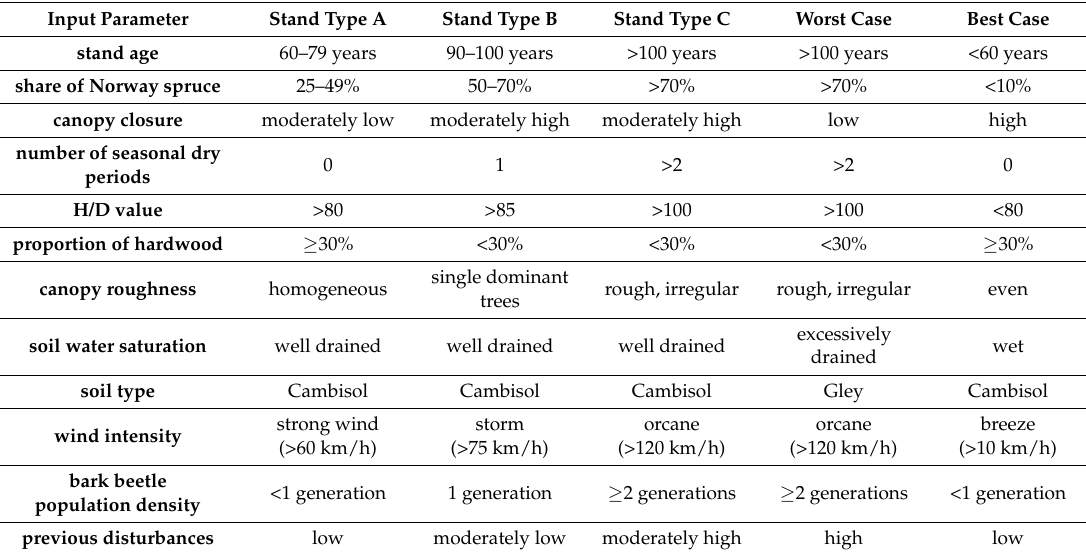
Table 1. Stand data for the case study